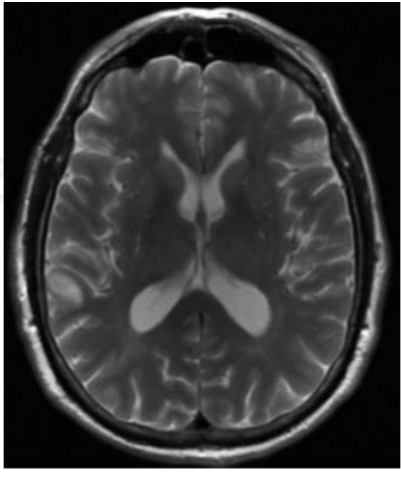
Figure 1. MRI of the brain showing septic emboli in the right cerebral hemisphere (MRT2TseTra2).